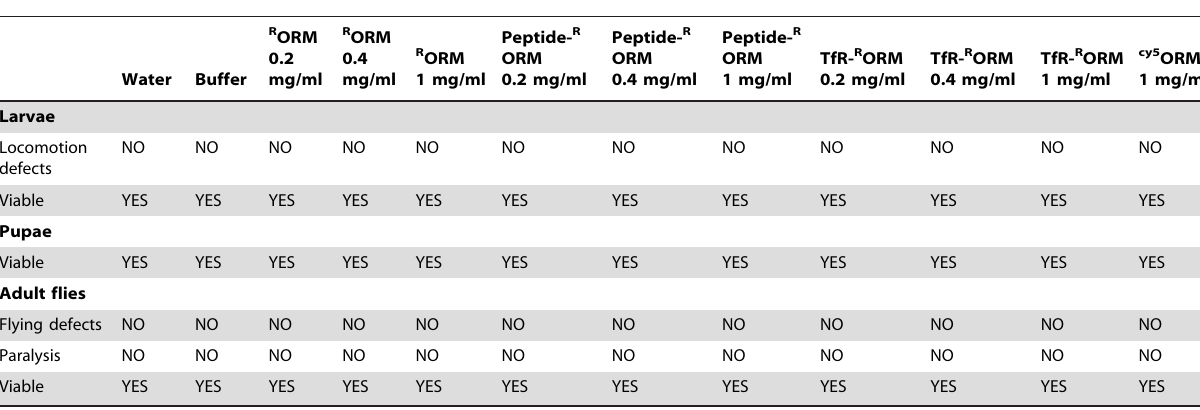
Table 1. Summary of ORMOSIL feeding experiments in